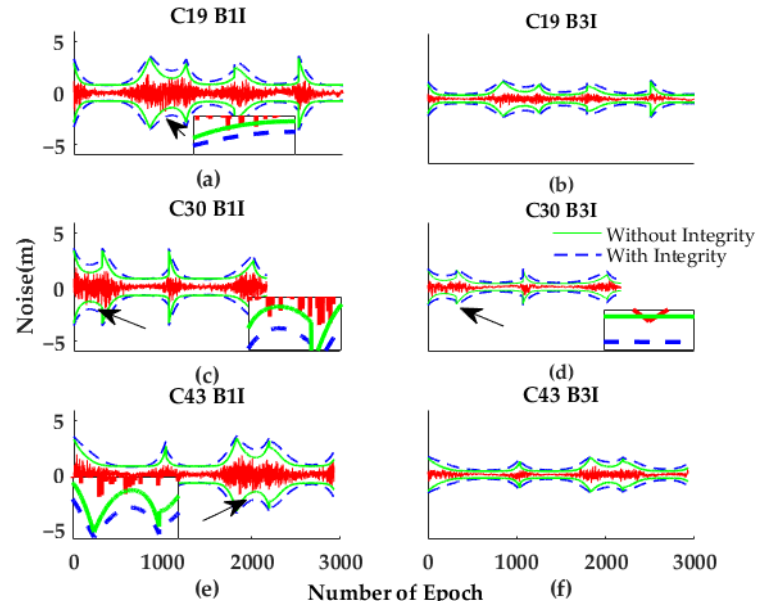
Figure 8. Range domain validation (CUSV, DOY 201–203, 2020). The sub-figures ( a , c , e ) are results of B1I and ( b , d , f ) are results of B3I, respectively. The red curves are multipath time series. The blue boundaries are from models based on two-inflation factors. And the green boundaries are from models based on single inflation factor.